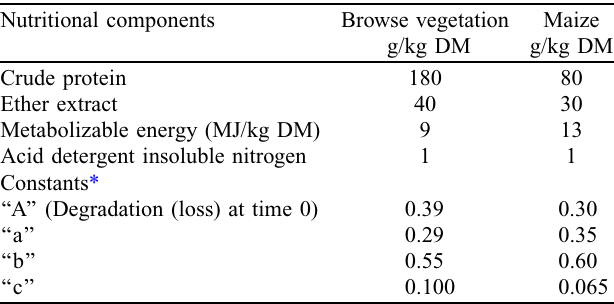
Table 1. Chemical composition (g/kg DM, except where stated) and feed degradation parameter considered to estimate nutrient supply of browsing vegetation and maize grain for Criollo kids naturally infected with gastrointestinal nematodes (GIN) during the rainy season. Nutritional